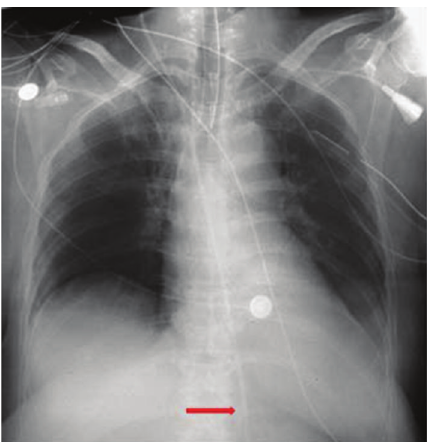
Figure 3: A chest radiograph on 2-month-old following cardiac surgery. A di ffi cult venous access prompted a right femoral vein access. The tip of the catheter has entered the right hepatic vein. Note the air at the tip of the catheter, which is a potential for air embolism (arrow).